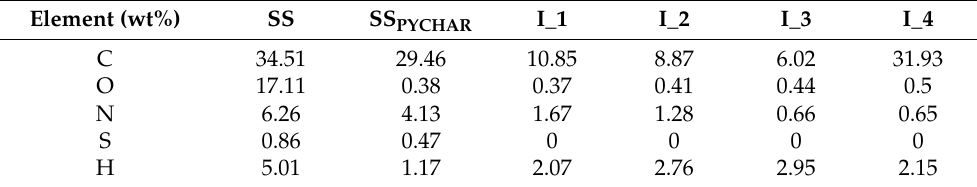
Table 2. The elemental composition.